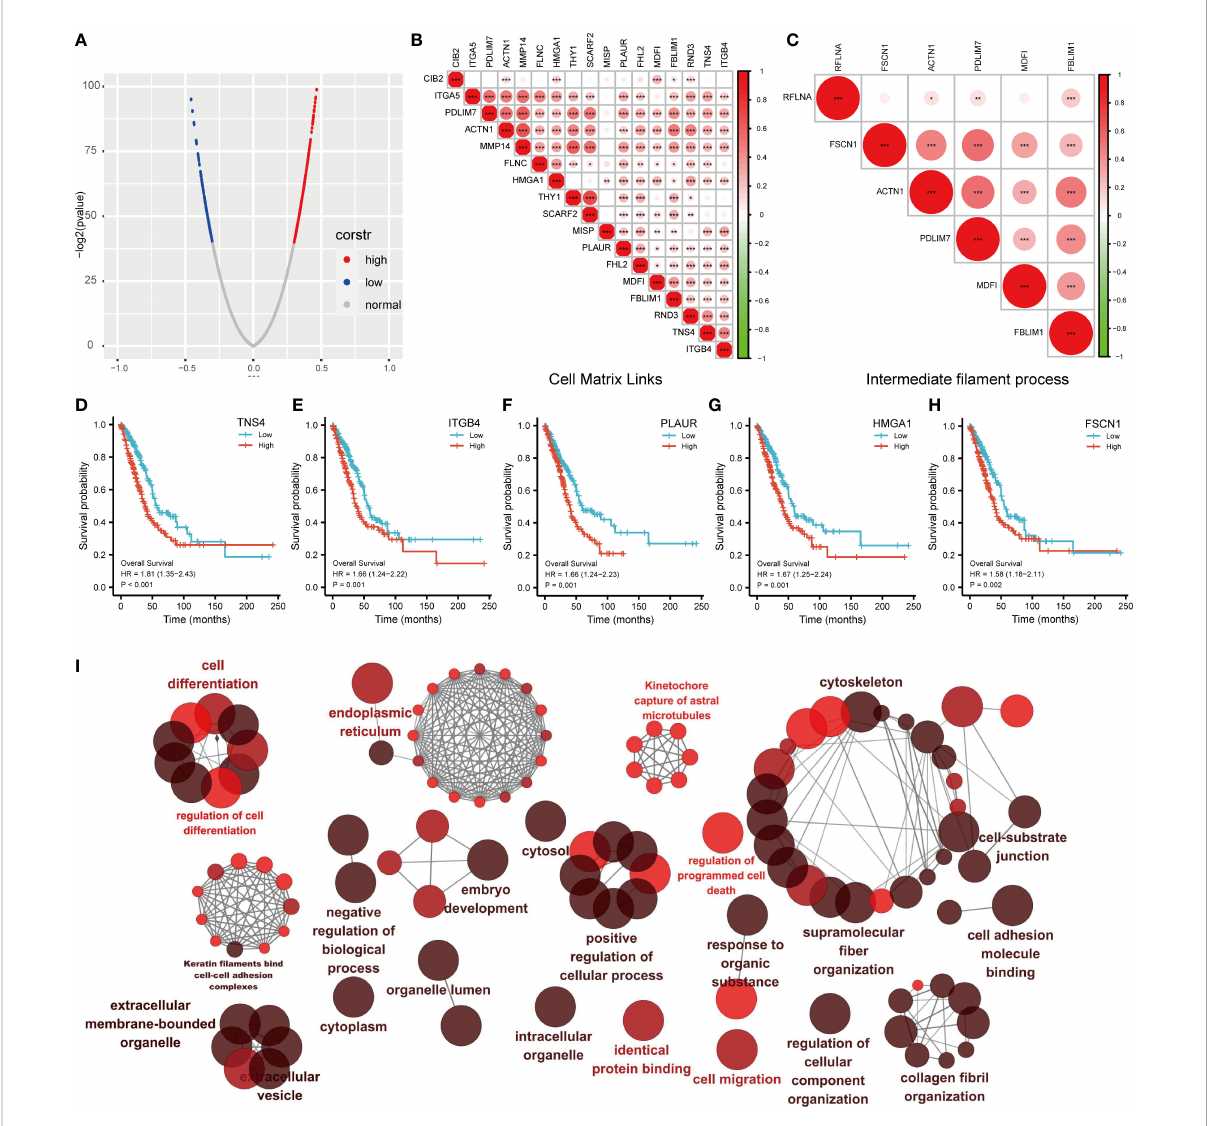
FIGURE 6 Correlation analysis of MDFI in LUAD (A) MDFI-related genes in LUAD, (B) Heat map of MDFI-related genes in Cell Matrix Links, (C) Heat map of MDFI- related genes in intermediate fi lament process, (D – H) Prognostic analysis of some MDFI-related genes in LUAD, (I) Visualization of the interaction network of genes strongly associated with MDFI by Cytoscape (ClueGo module). Node size indicates the mapped gene number; the node color schedule represents the p value, the darker the color, the smaller the p-value. (A – H) Data from TCGA. *p < 0.05, **p <0.01, ***p <